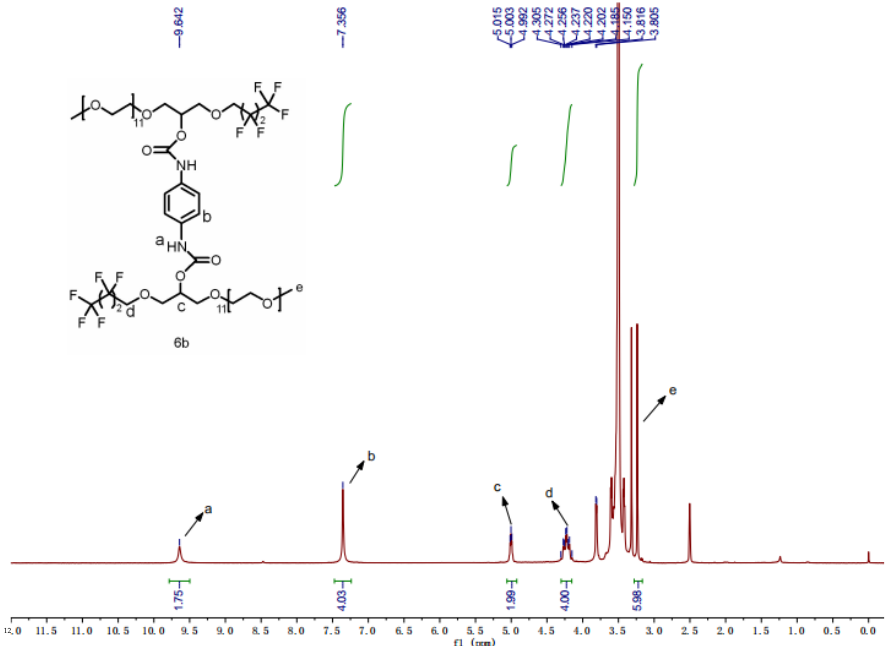
Figure 2. 1 H NMR spectrum of 6b .